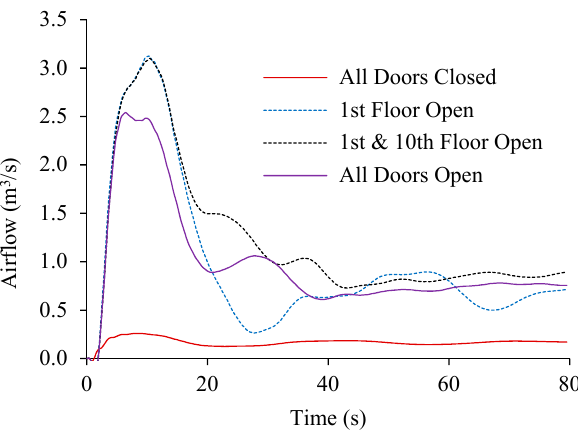
Figure 19. Stairwell door openings e ff ect on airflow into the 1st floor stairwell (A 2 ) for very leaky envelopes.